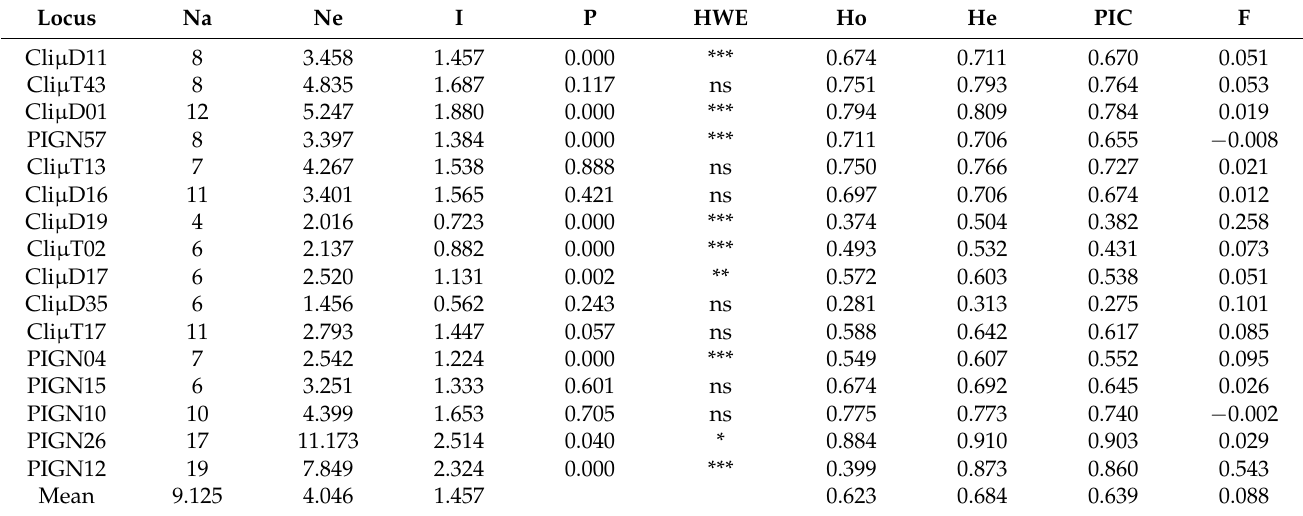
Table 2. Genetic diversity parameters across 17 microsatellite markers.